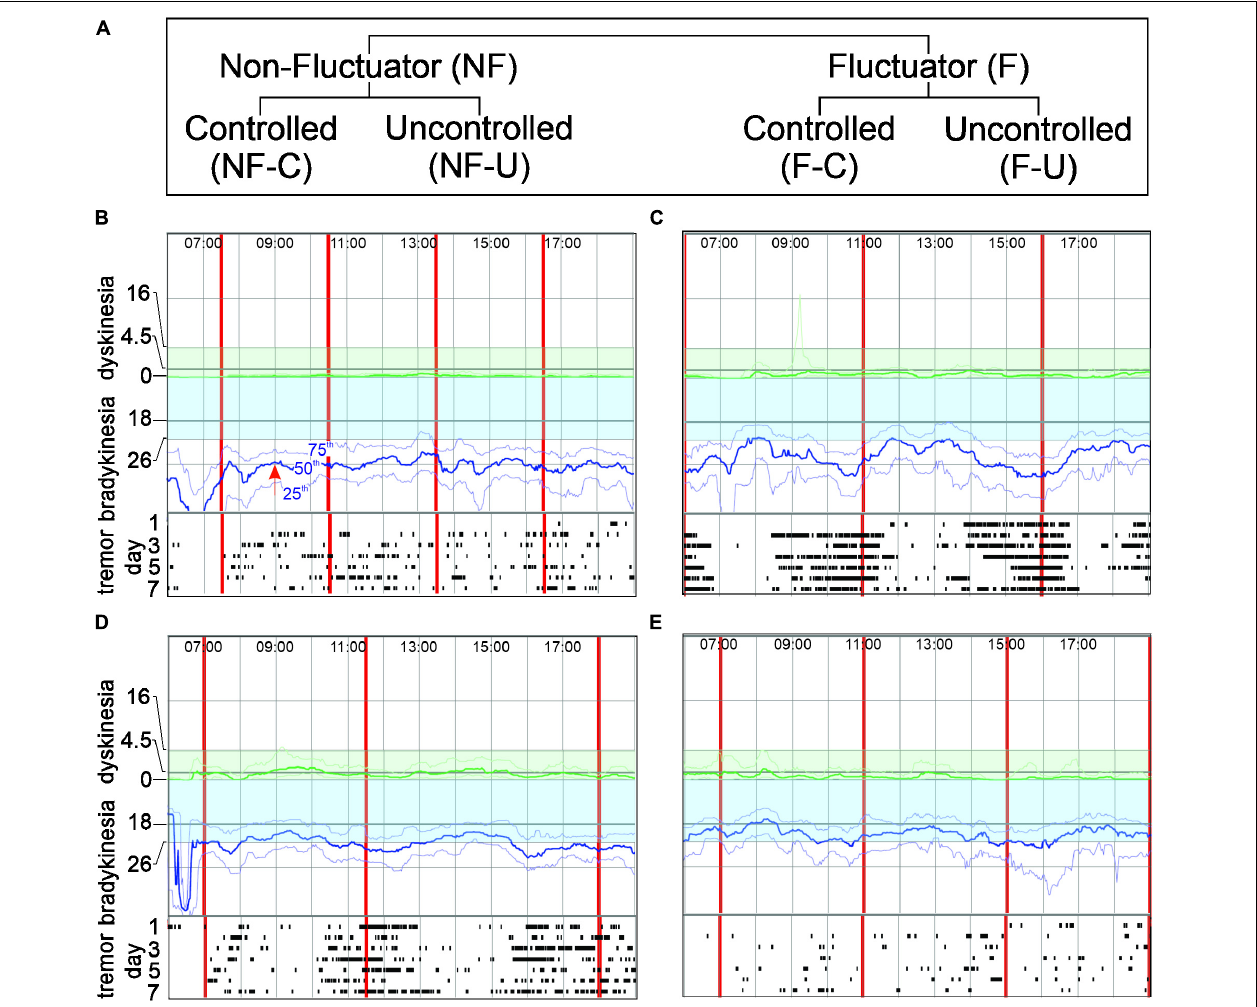
FIGURE 1 | Panel (A) shows the Fluctuator classification. Panels (B–E) show PKG excerpts representing each classification. In each PKG: X axis- time of day (top); vertical red lines-time of each dose; Y axis-BKS and DKS scales. Bradykinesia target region is shaded blue. Moving BKS 50 [red arrow, Panel (B) shows moving BKS 50 at 9:00] is a heavy blue line: moving BKS 25 and moving BKS 75 are lighter blue lines above and below moving BKS 50 (B) . Rasters below each graph show tremor: each line represents a day and dots indicating 2-min epochs when tremor was present. DKS severity increases from zero to top of graph and target region is shaded green. Moving DKS 50 is a heavy green line and moving DKS 75 and moving DKS 25 are lighter green lines above and below (respectively). (B) Non-fluctuator Uncontrolled (NF-U). Moving BKS unchanged following levodopa doses (Non-fluctuator) and lies outside the target range all day (Uncontrolled) and tremor does not vary with dose. (C) Fluctuator Uncontrolled (F-U). Moving BKS falls following each levodopa doses (Fluctuator) but even at peak response is above target range on most days (Uncontrolled). Tremor reduces with each dose. (D) Fluctuator Controlled (F-C). Moving BKS falls following each levodopa doses (Fluctuator) to